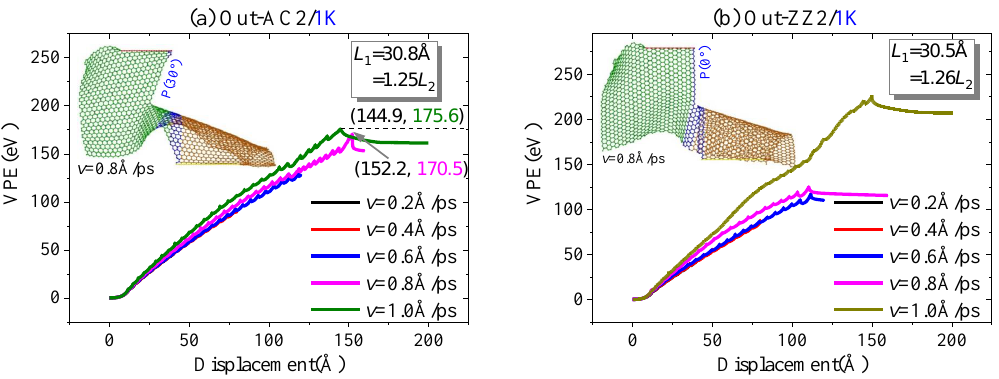
Figure 10. Curves of VPE vs. out-of-plane tearing of graphene ribbons with three aspect ratios at different speeds at 1 K: ( a ) armchair crack; ( b ) zigzag crack. Second, the value of AR also has a slight influence on the path of crack propagation; Figure 11a indicates that the VPE curves have a slight gap and the slopes are about 1.68 eV/Å when tearing the sheet along the armchair crack, which expands along with the path of P(30°). When tearing the zigzag crack, the path of crack propagation is along P(0°). The